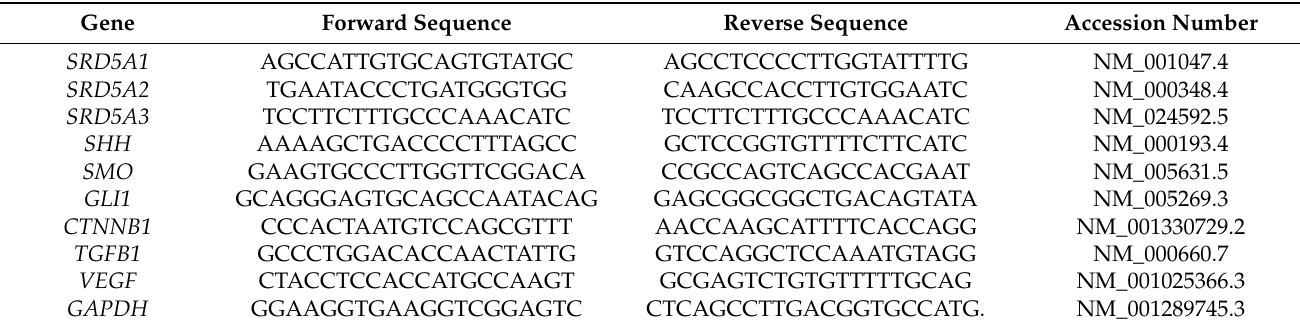
Table 1. List of forward and reverse primer sequences.